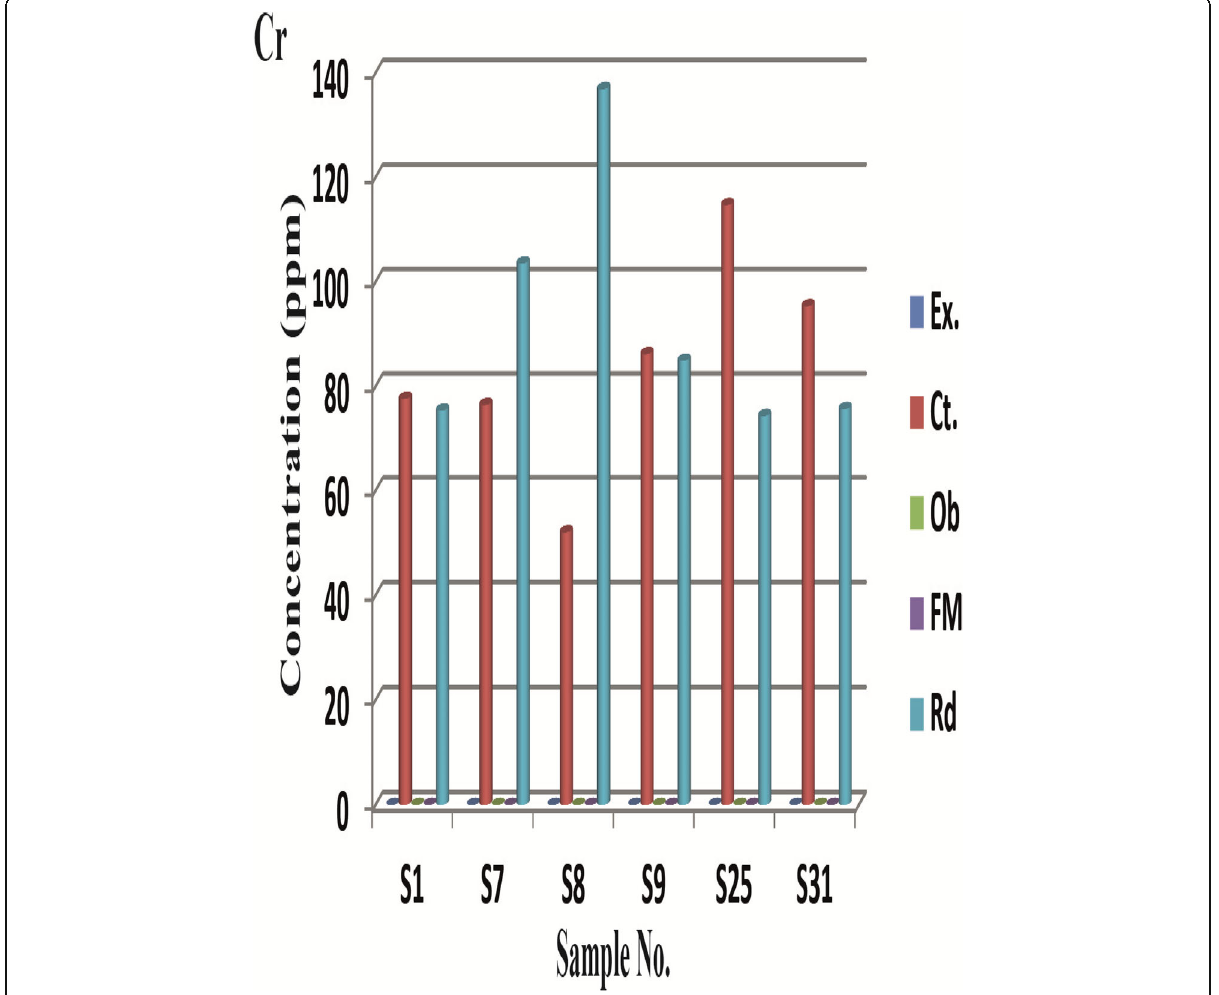
Fig. 5 Relative distribution of Cr among the various soil fractions in the study area